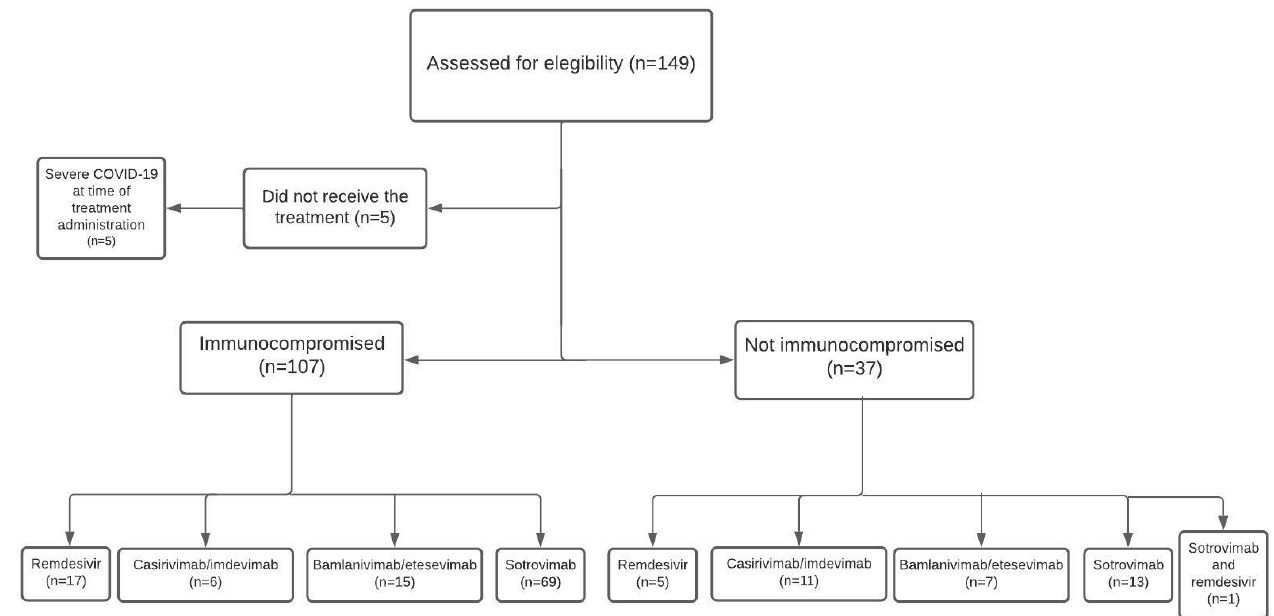
Figure 1. Study flowchart.